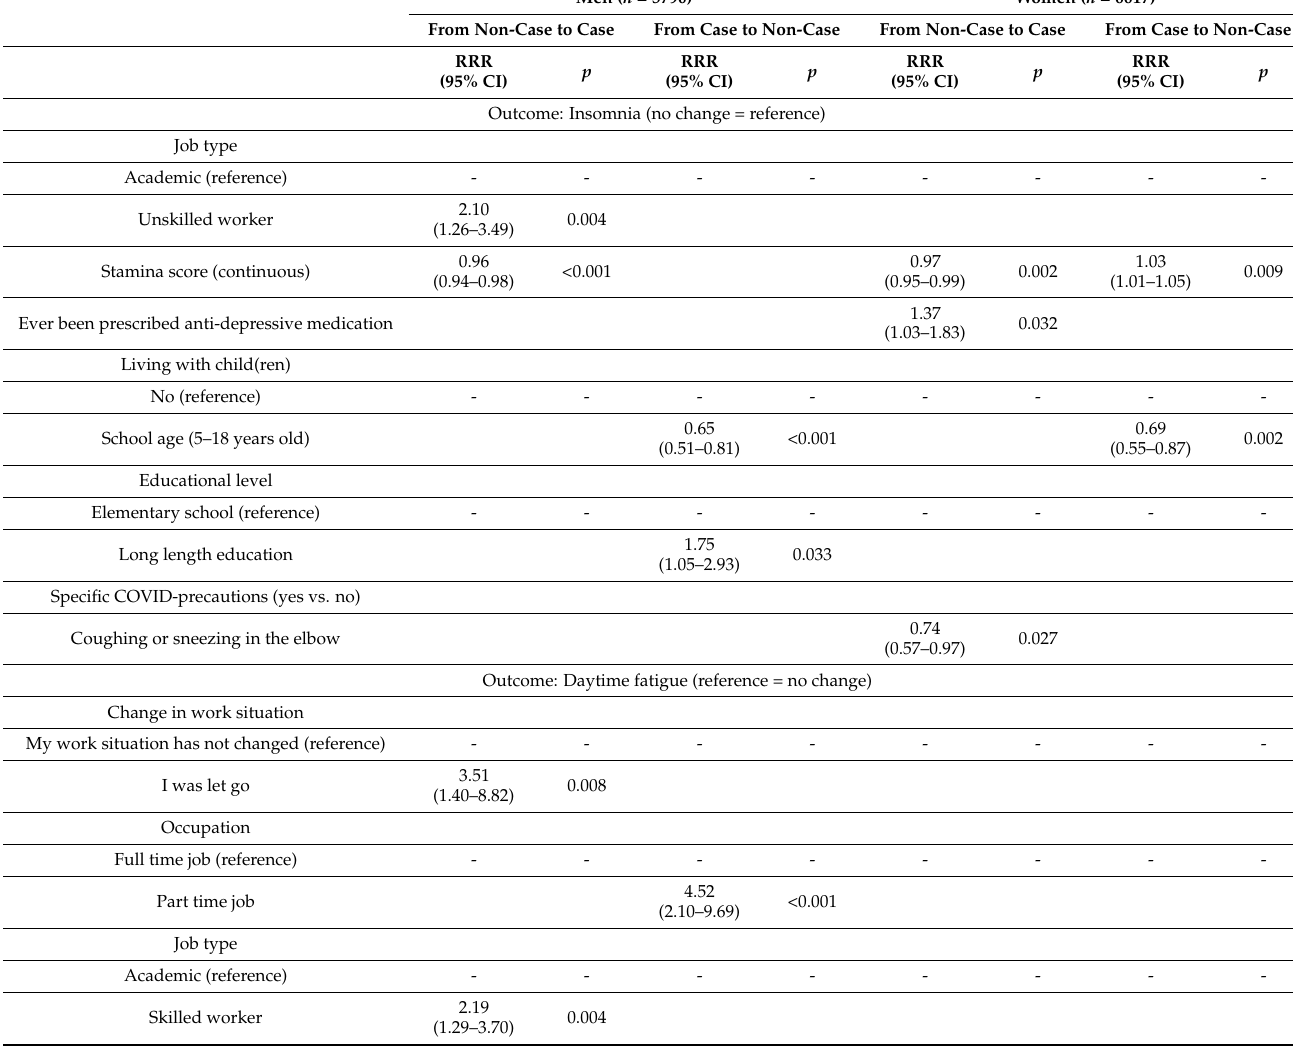
Table 4. Multinomial logistic regression analyses displaying relative risk ratios (RRR). Identification of characteristics associated with developing a poor quality of sleep phenotype or becoming free of a poor quality of sleep phenotype (displaying risk estimates for covariates with a p value < 0.05 in the complete model). Men ( n = 5790) Women ( n = 6617) From Non-Case to Case From Case to Non-Case From Non-Case to Case From Case to Non-Case RRR (95%